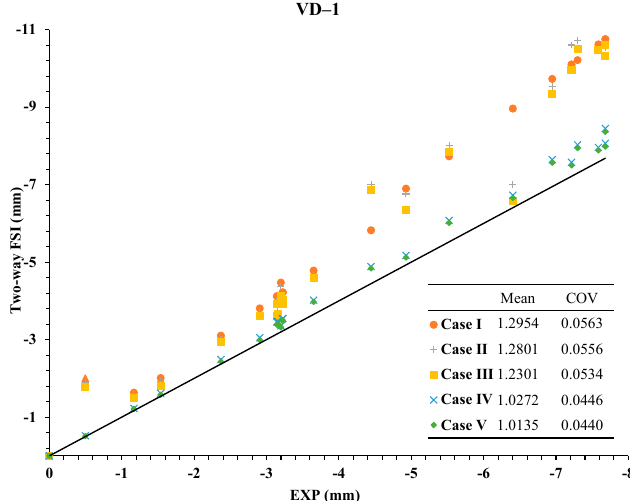
Figure 26. Statistical analysis results of two-way FSI for deflection versus time increments ( ∆ t ) at VD-1.